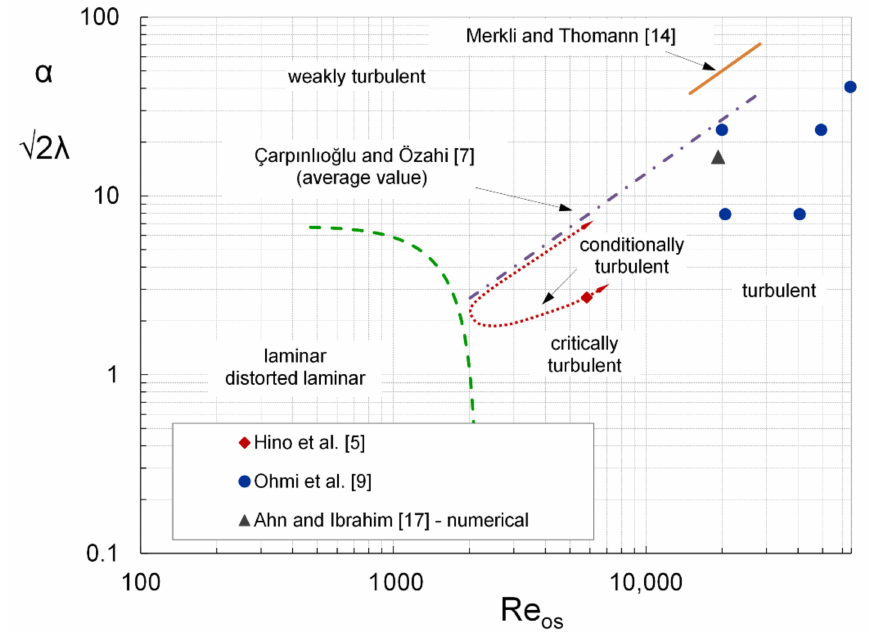
Figure 1. Characteristic diagram indicating the onset of transition and the resulting different flow regimes. k = 750 based on the extensive review by Çarpınlıo˘glu and Özahi [7] and k = 400 according to Merkli and Thomann [14]. Data used for comparison to computational results (Hino et al. [5], Ohmi et al. [9], and Ahn and Ibrahim [17]) are indicated by